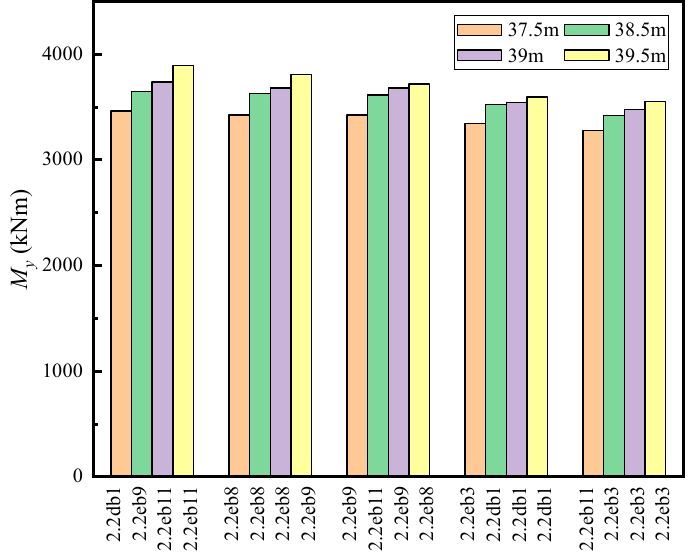
Figure 10. Histogram of M y at blade root. (The label of the load case: the first letter refers to wind speed, “d” for 20 m/s and “e” for 25 m/s; the second letter refers to the type of fault and “b” for pitch runaway (blade 1 pitcher towards fine at − 8 deg/s); the last number refers to the random seed num- ber).